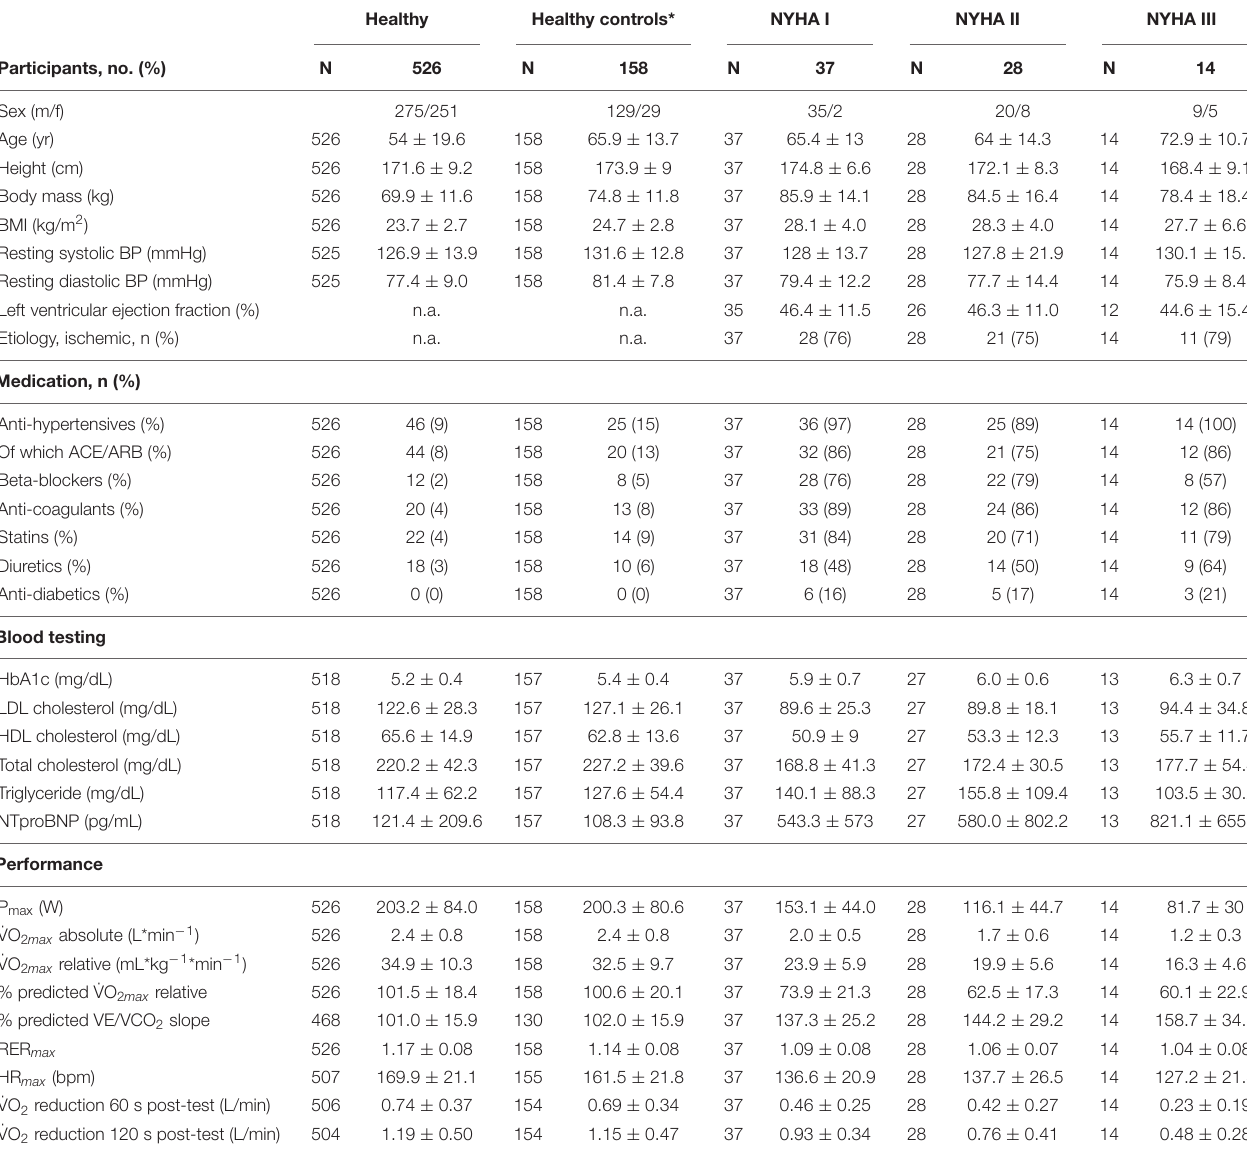
TABLE 1 | Descriptive characteristics of the study population separated into healthy participants and patients with heart failure by NYHA functional classes. Healthy Healthy controls* NYHA